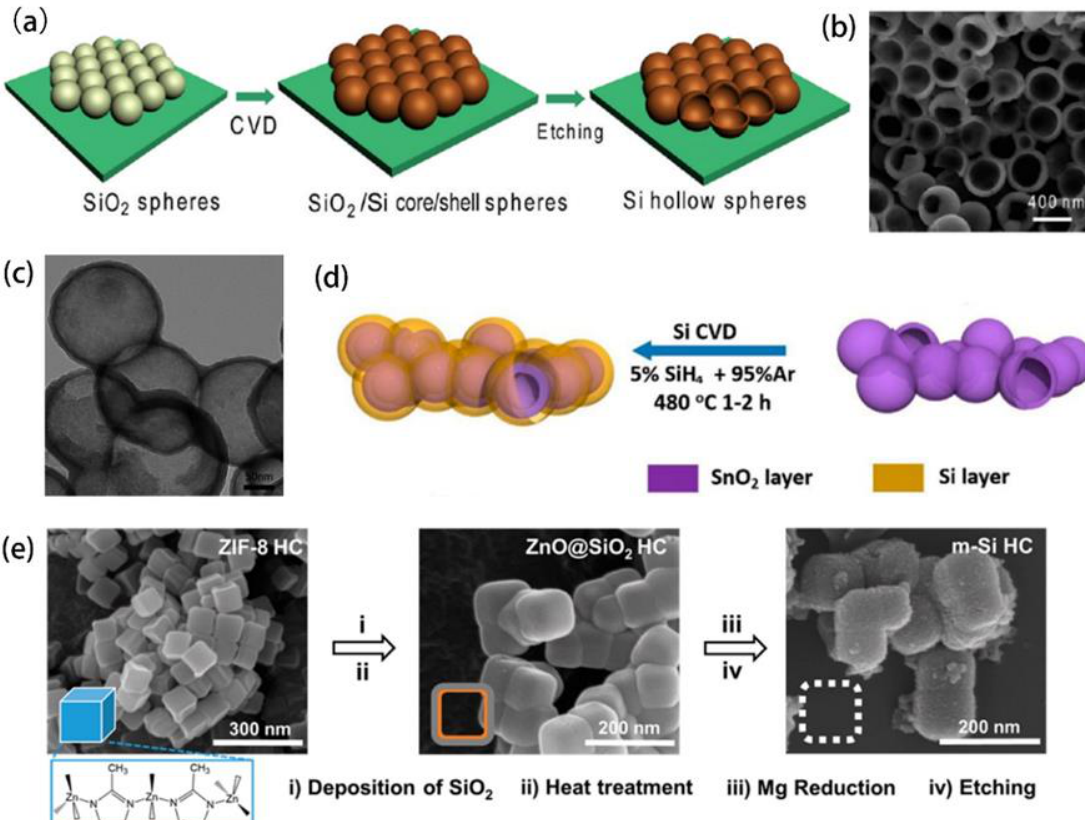
Figure 12. ( a ) Schematic illustration of the preparation process ( b ) SEM image of Si hollow spheres from removing SiO 2 spheres [92] ( c ) TEM image and ( d ) Schematic illustration of the preparation process of Si hollow spheres from removing SnO 2 layer [93]. ( e ) SEM images illustrating synthetic routes of m-Si HC: (i) Deposition of SiO 2 shell coating on ZIF-8 NC, (ii) heat treatment for calcination, (iii) MRR, and (iv) etching with HCl [96]. Reprinted with permission from [92]. Copyright 2011 American Chemical Society. Reprinted with permission from [93]. Copyright 2017 American Chemical Society. Reprinted with permission from [96]. Copyright 2017 American Chemical Society.